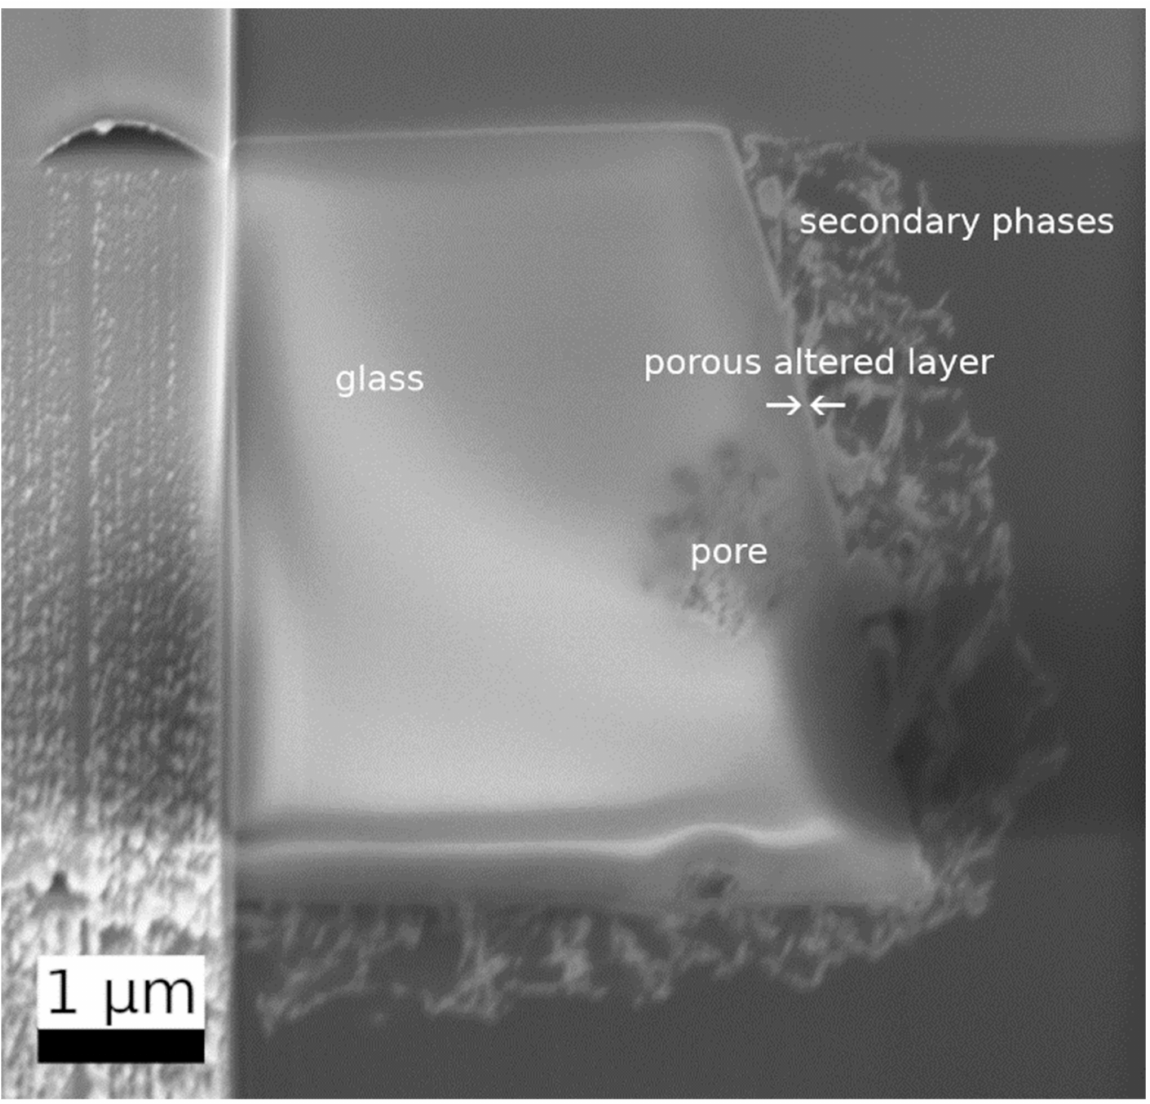
Figure 8. SEM in-lens secondary electron image of the thinned glass grain with the dimensions 2.9 µ m (top), 4.2 µ m (bottom), height 4.6 µ m. The pristine glass was surrounded by a very thin altered layer (between the arrows) on which an about 1 µ m thick layer of fibrous secondary phases was